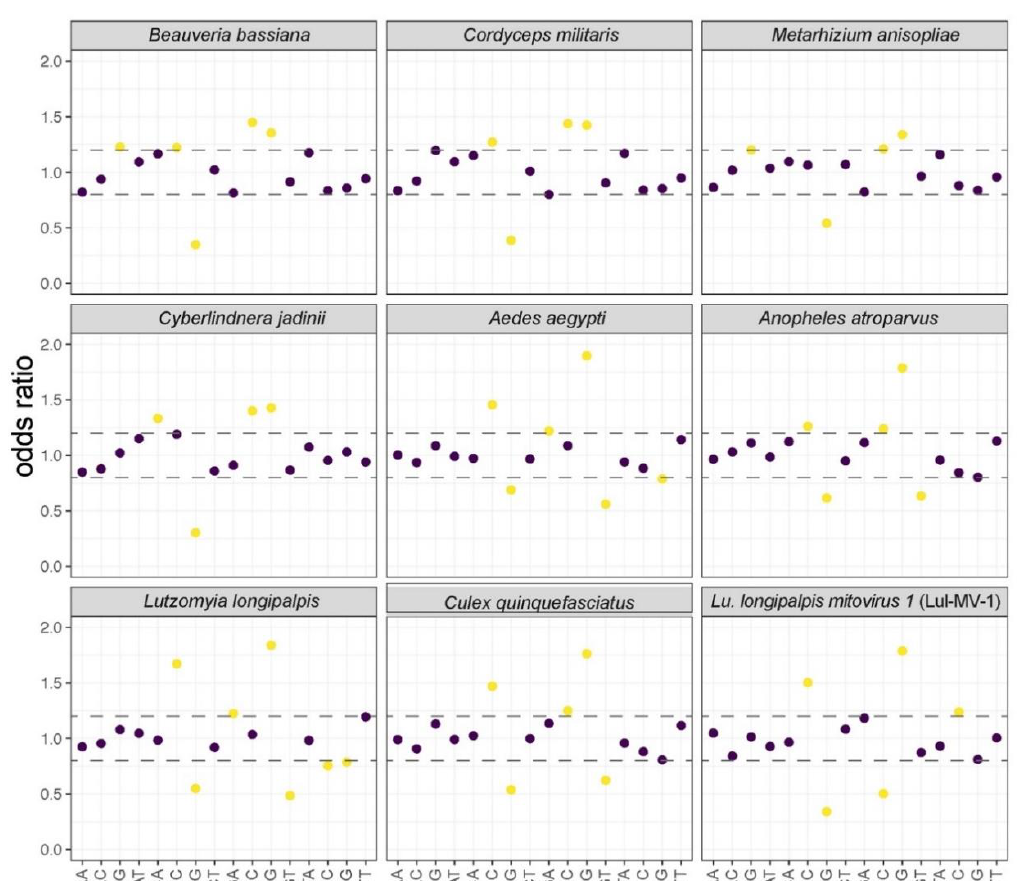
Figure 4. Dinucleotide frequency of Lul-MV-1 and nuclear genomes of fungi that commonly infect insects. Yellow circles represent dinucleotide odds ratios which are highly biased regarding the expected frequencies. Purple circles refer to dinucleotide odds ratios within the unbiased region (delimited by dashed lines). Dashed lines indicate cutoffs values of 0.78–1.25.